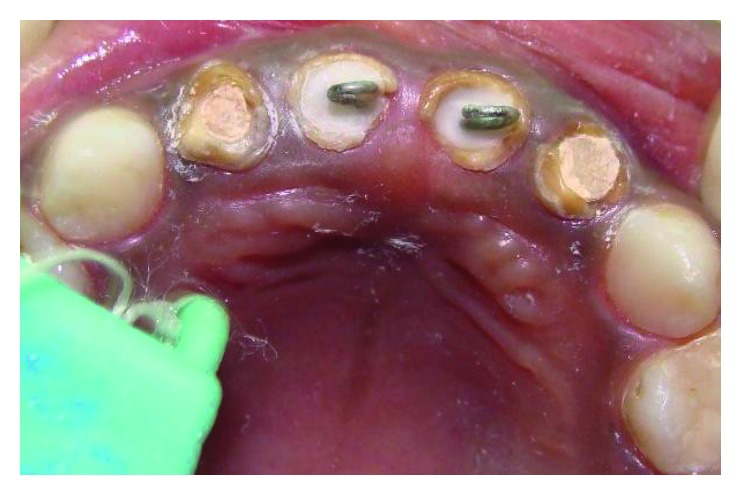
Gamma post cemented.